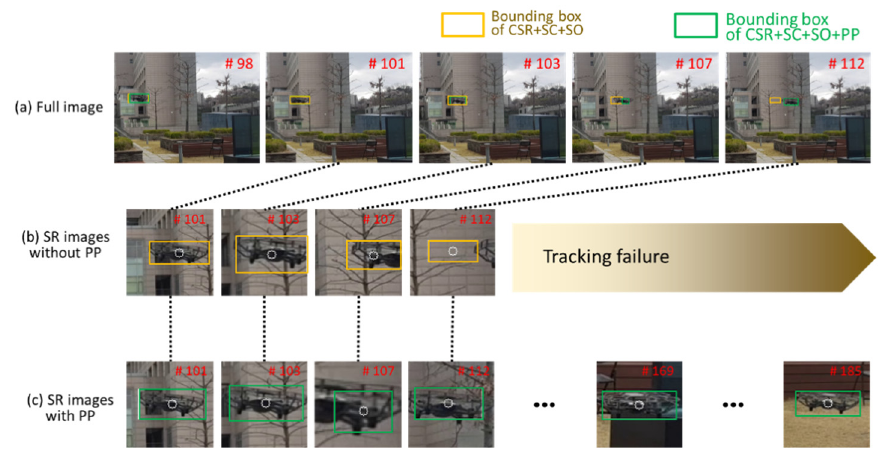
Figure 10. Recovery example of PP.